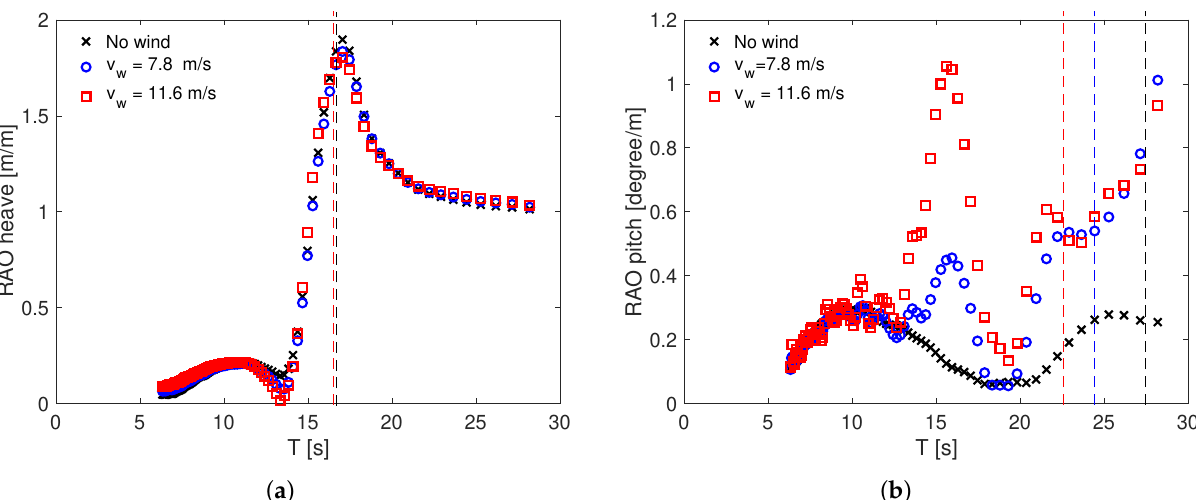
Figure 14. Concomitant effects of wind and waves on the RAO at different wind velocities (without TA): ( a ) heave and ( b ) pitch. The dashed lines represent the experimental natural periods from Table